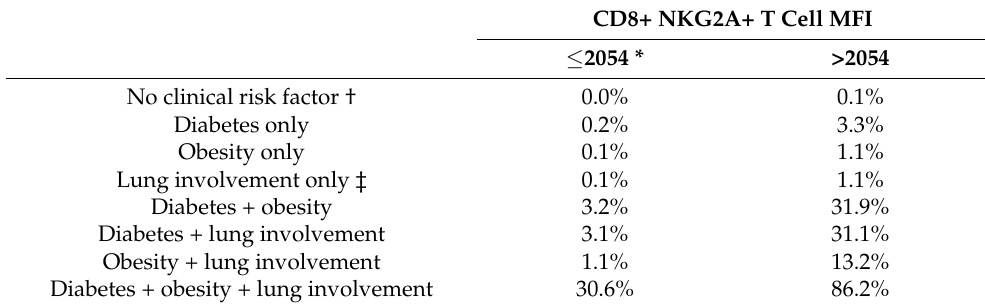
Figure 2. Model for the prediction of the risk of COVID-19 progression in the presence of increased CD8+ T-cell NKG2A MFI and clinical variables. HLA-DR, human leukocyte antigen DR isotope; mAb, monoclonal antibody; MFI, mean fluorescent intensity; NKG2A, natural killer group 2-member A. Table 5. Probabilities of COVID-19 progression according to the final logistic model.